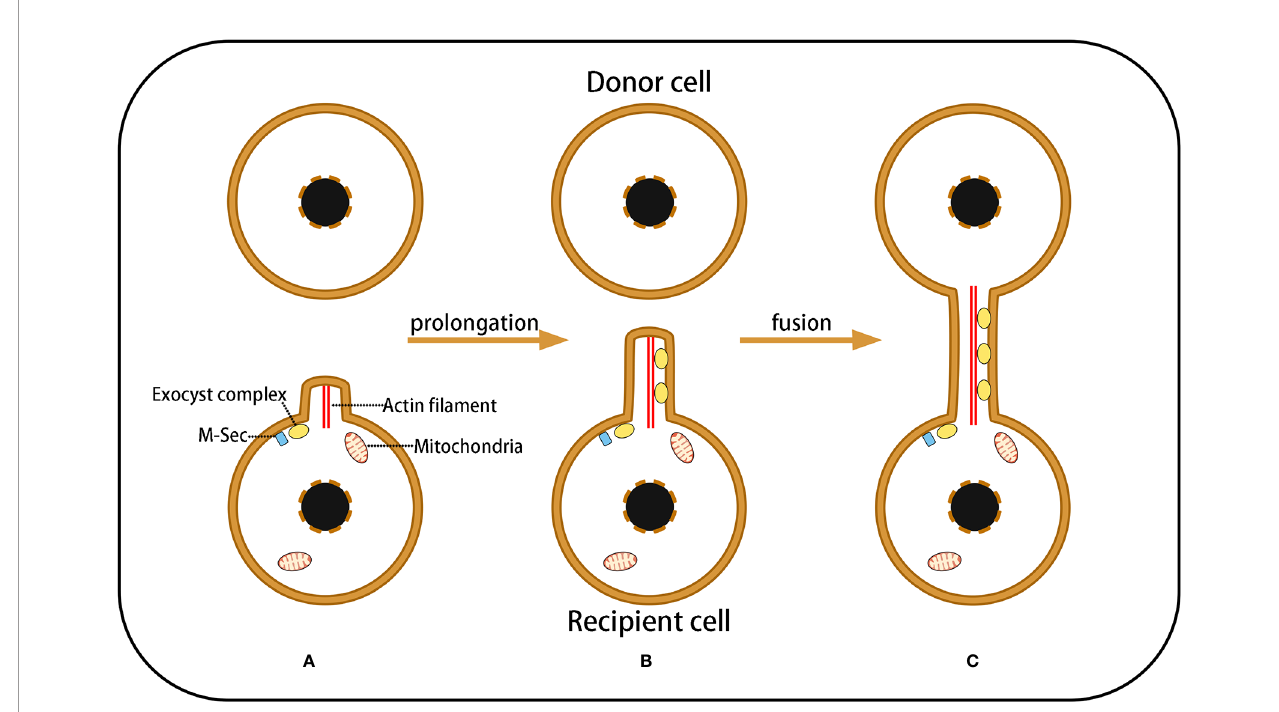
FIGURE 2 | Three Stages of TNT Formation. (A) Under the control of M-sec and exocyst complexes, cells needing healthy mitochondria emit a membrane protrusion containing F-actin; (B) Exocyst complexes induce F-actin remodeling, resulting in membrane protrusion prolongation that forms a fi lopodium-like membrane structure; (C) The prolongated membrane protrusion contacts the target cell (mitochondrial donor cell) and fuses with the target cell membrane to form a membrane channel connecting the cytoplasm of the two cells, which is termed a TNs. However, the fusion mechanism of the phospholipid bilayers of the donor and recipient cells remains